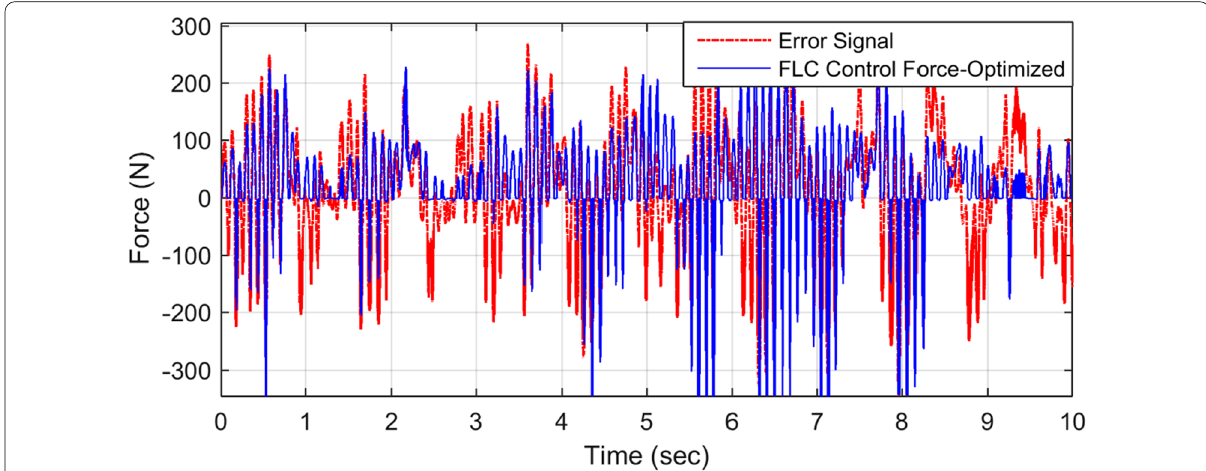
Fig. 9 Error signal and control